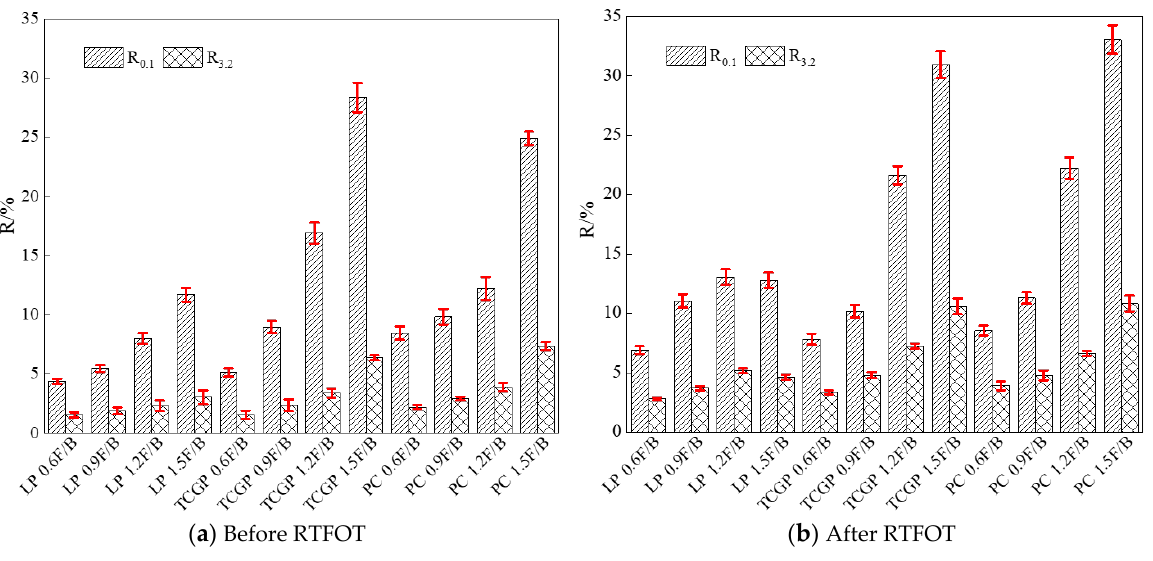
Figure 13. Test results of R of different emulsified asphalt mastics (64 ℃ ).